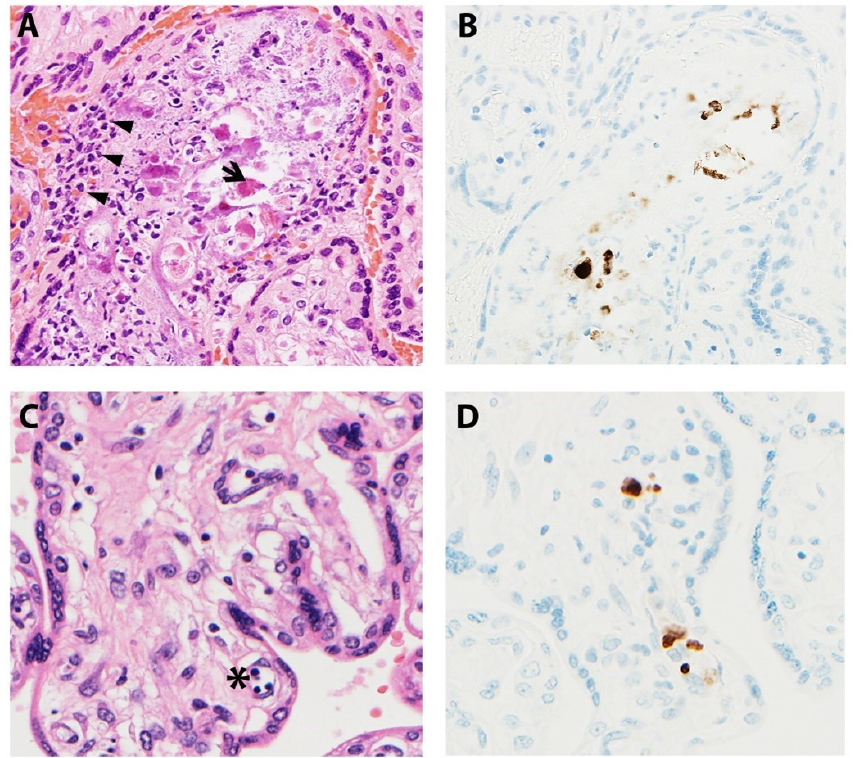
Figure 4. Representative images of placentas infected by CMV. ( A ) Arrowheads illustrate chronic villitis and arrow indicates degraded CMV inclusions and cytopathic effect; ( B ) Immunostaining highlights viral inclusions; ( C ) Asterisk indicates erythroblastosis in early hydropic third trimester placenta; ( D ) Immunostaining highlights scattered positive CMV cells.